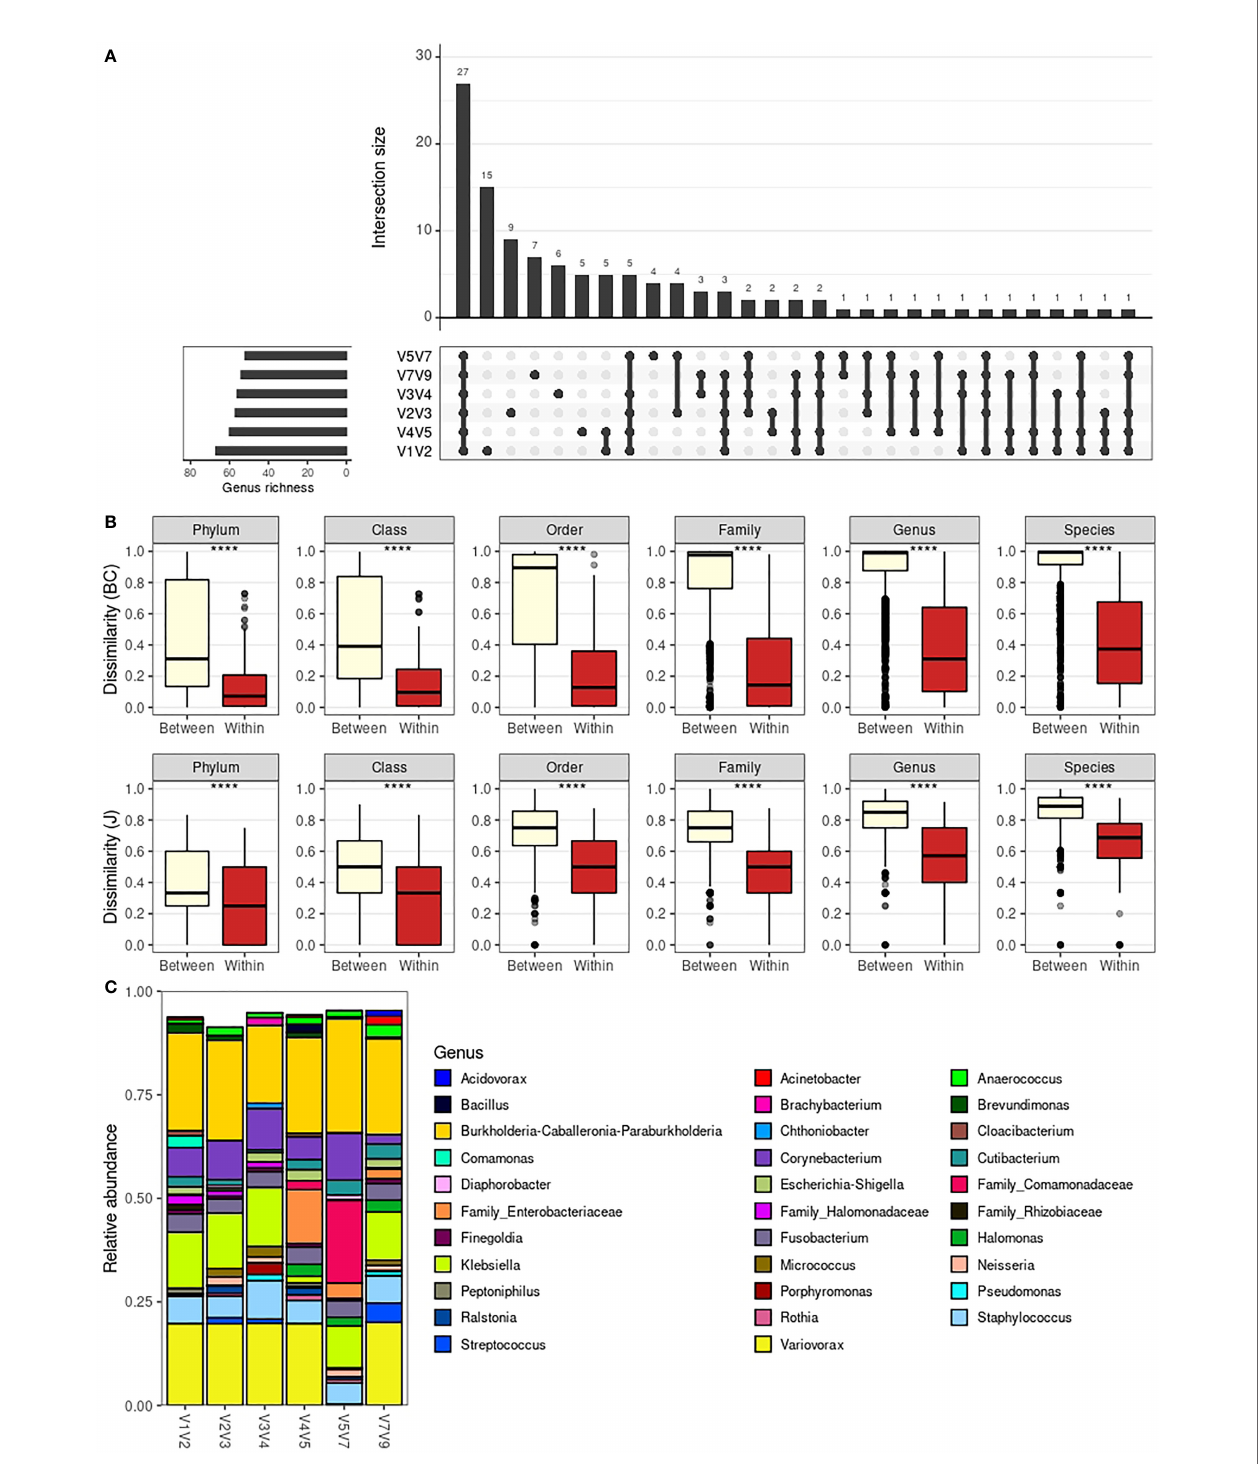
FIGURE 3 | Taxonomic composition across 16S rRNA amplicon-speci fi c datasets. (A) Barplot depicting intersections between the genera detected in each amplicon-speci fi c dataset. Total rIchness at genus level is shown in the lower-left subplot. (B) Boxplot comparing dissimilarities between different libraries and within the same libraries as pro fi led with different amplicons. Dissimilarity metrics considered are Bray-Curtis (BC) and Jaccard (J). Statistical signi fi cance was evaluated by the Mann-Whitney U test. The boxes highlight the median value and cover the 25th and 75th percentiles, with whiskers extending to the more extreme value within 1.5 times the length of the box. (C) Average genera relative abundance per amplicon-speci fi c dataset. Only the 32 most abundant genera are shown (based on minimum relative abundance in at least one sample, which is adjusted for each plot). ****P <